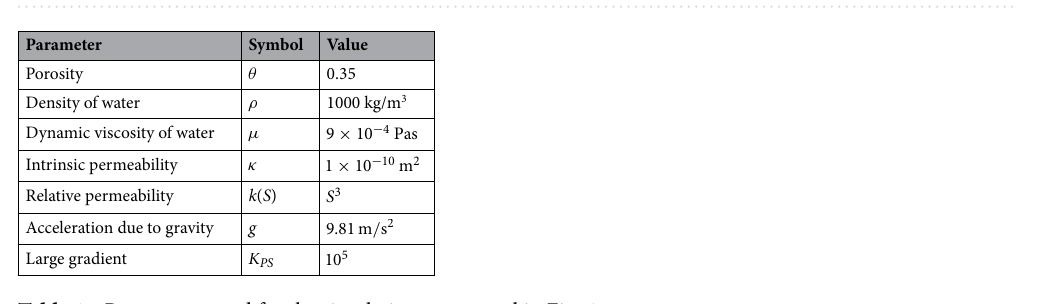
Table 1. Parameters used for the simulations presented in Fig. 4.